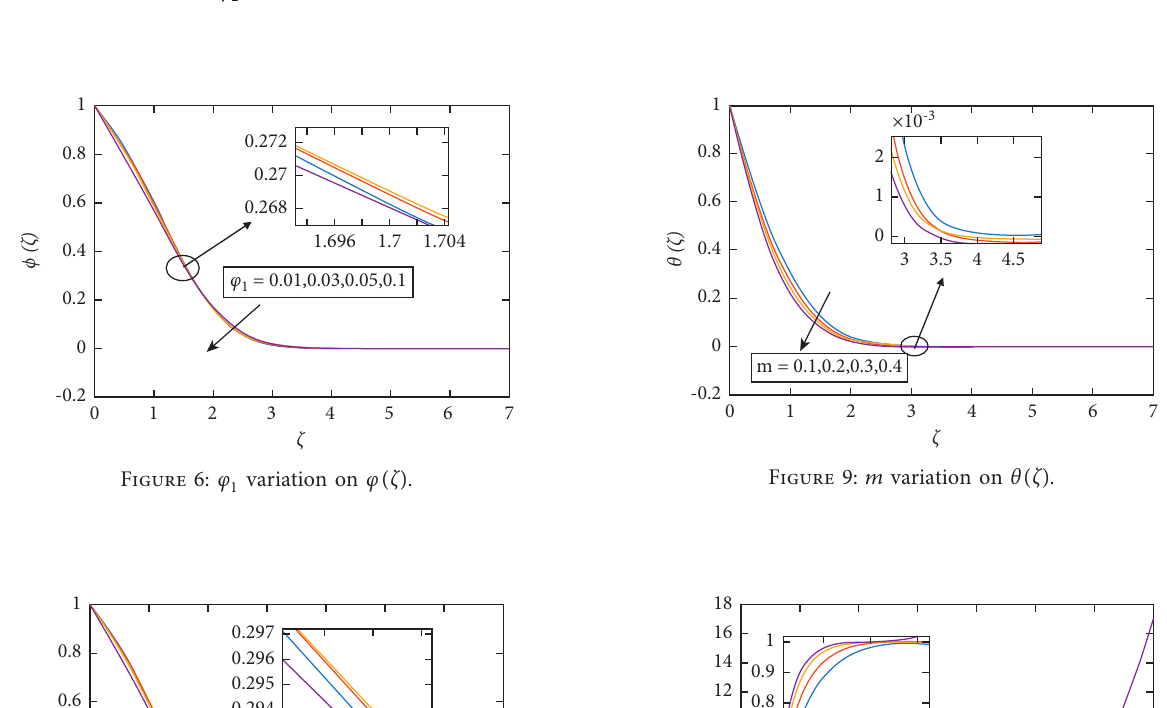
Figure 8: m variation on f ′ ( ζ ) .